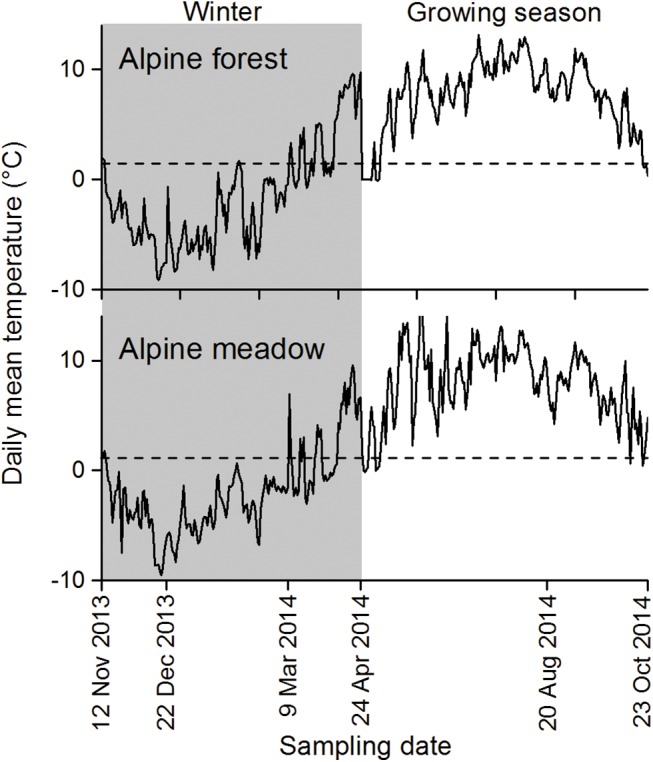
Daily mean temperature in the alpine forest and the alpine meadow during the one-year decomposition experiment.Wintertime is shaded gray.